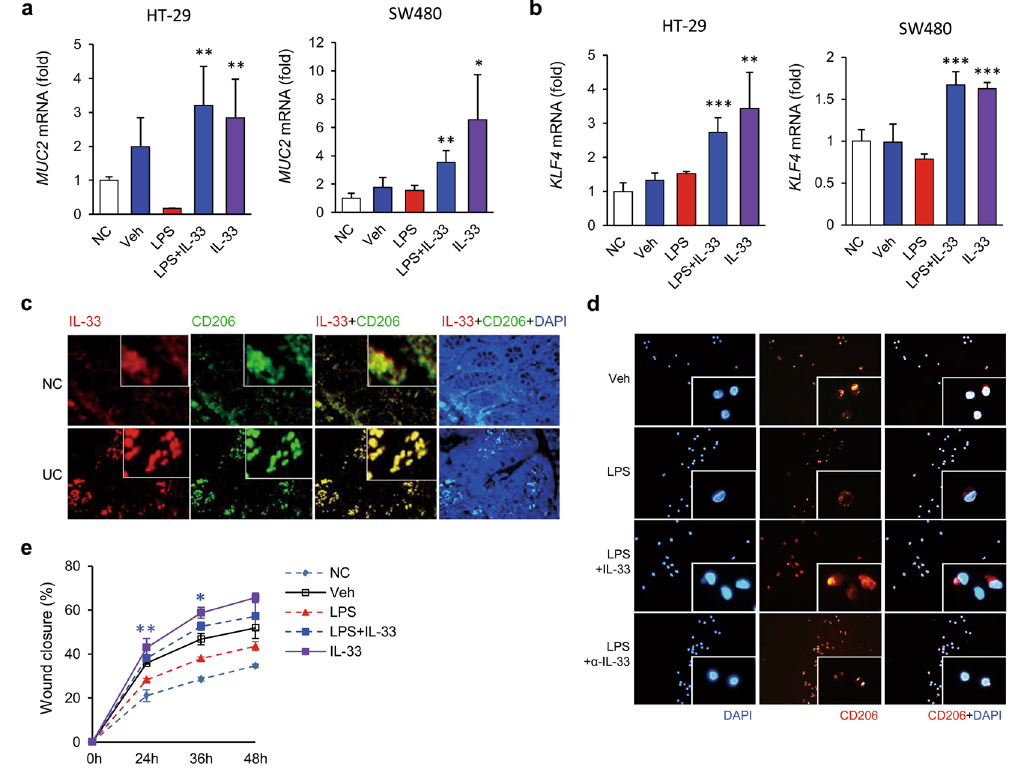
Figure 6. IL-33 drives goblet cell restoration and wound healing via modulation of macrophages toward the M2 phenotype. ( a , b ) Effects of IL-33-treated macrophage on goblet cell differentiation. THP-1 monocyte- derived macrophages were treated with vehicle (Veh) or lipopolysaccharide (LPS, 100 ng/ml), with or without IL-33 (20 ng/ml) for 48 hours. Conditioned media from the macrophages were harvested. HT-29 and SW480 cells were treated with normal control media (NC) or the conditioned media for 48 h. Total RNA was extracted from HT-29 and SW480 cells and analysed by quantitative RT-PCR MUC2 ( a ) and KLF4 ( b ) mRNA expression levels were normalised to that of β -actin . Data are presented as means ± SD (n = 4). ( c ) Co-localisation of IL-33 and CD206 in human colon tissues. Representative images showing that IL-33 is localised to colonic intestinal epithelial cells and lamina propria mononuclear cells. Moreover, IL-33 expression is markedly increased in CD206 + cells (M2 macrophages). The immunolocalisation of IL-33 (red) and CD206 (green) in colon tissue samples from normal controls (NC, n = 3) and patients with ulcerative colitis (UC, n = 4) was evaluated by immunohistochemistry using fluorescent conjugated antibodies. Nuclei were counterstained with DAPI (blue). Original magnification: x400. ( d , e ) IL-33 drives human monocyte-derived macrophages toward the M2 phenotype and wound repair. Monocytes were isolated from PBMCs (peripheral blood mononuclear cells) and differentiated into macrophages using human recombinant GM-CSF for 7 days. Macrophages were cocultured with the HT-29 cells and wound healing assays were performed. ( d ) Representative images of CD206 + cells. Monocyte-derived macrophages from patients with IBD (n = 2) were treated with IL-33 and stained with fluorescent antibodies against CD206 (red). Nuclei were counterstained with DAPI (blue). Original magnification: x400. ( e ) Wound healing assay. Monocytes were isolated from PBMCs and differentiated into macrophages for 7 days. HT-29 cells were cocultured with or without the macrophages (NC) and wound healing assays were performed. Data are presented as means ± SD (n = 3). * P < 0.05 vs. LPS, ** P < 0.01 vs. LPS, *** P < 0.005 vs. LPS as assessed by Student’s t -test. Veh, treated with vehicle; IL-33, treated with hrIL-33; LPS, treated with lipopolysaccharide; α -IL-33, treated with anti-IL-33 antibodies (IL-33